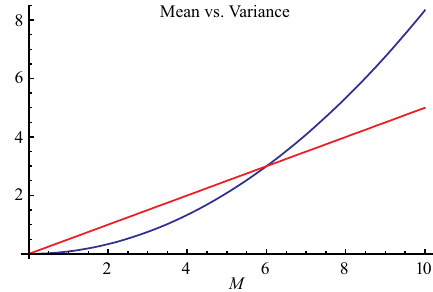
Fig. 7. Mean & variance of uniform distribution